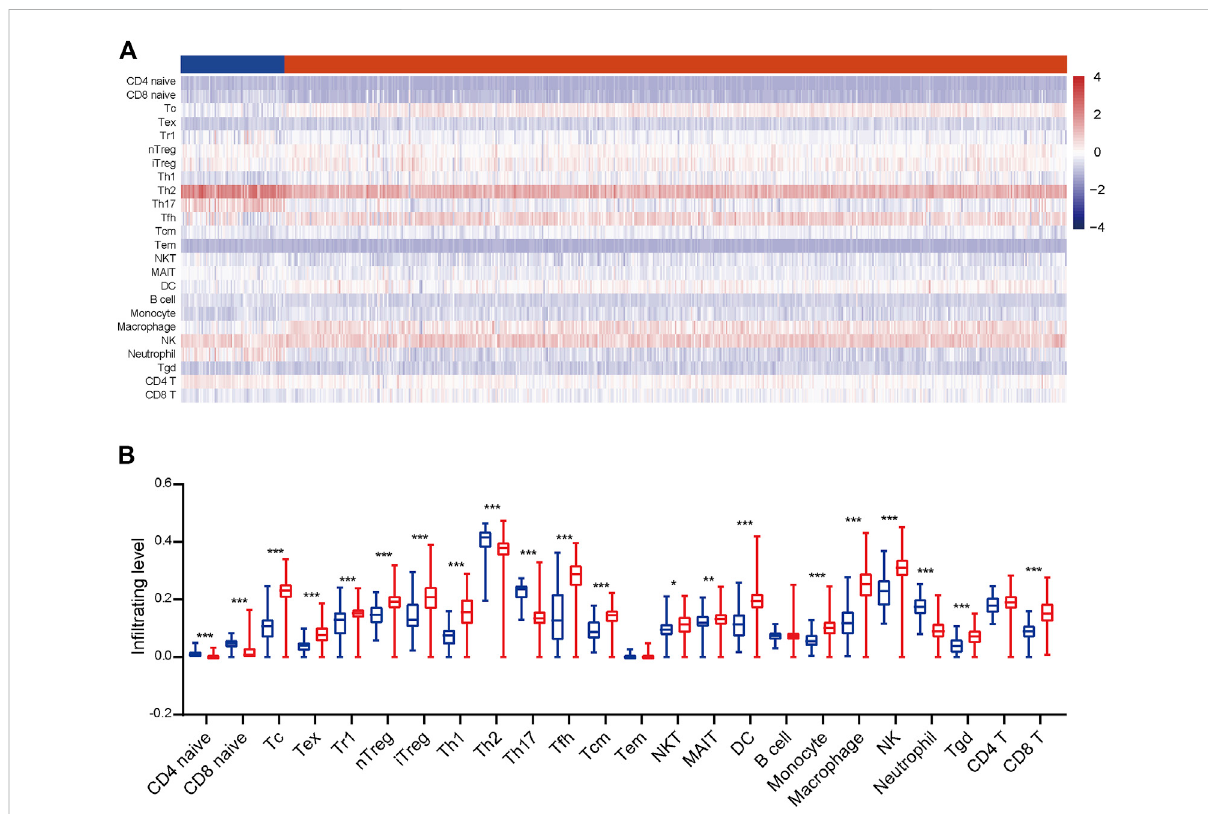
FIGURE 2 The distribution of TIICs in ccRCC. (A) The heatmap of the 24 TIICs abundance based on TCGA data. Red represents high abundance, and blue represents low abundance. (B) The in fi ltrating abundance of 24 TIICs in normal and tumor tissues. Signi fi cance was calculated with Student ’ s